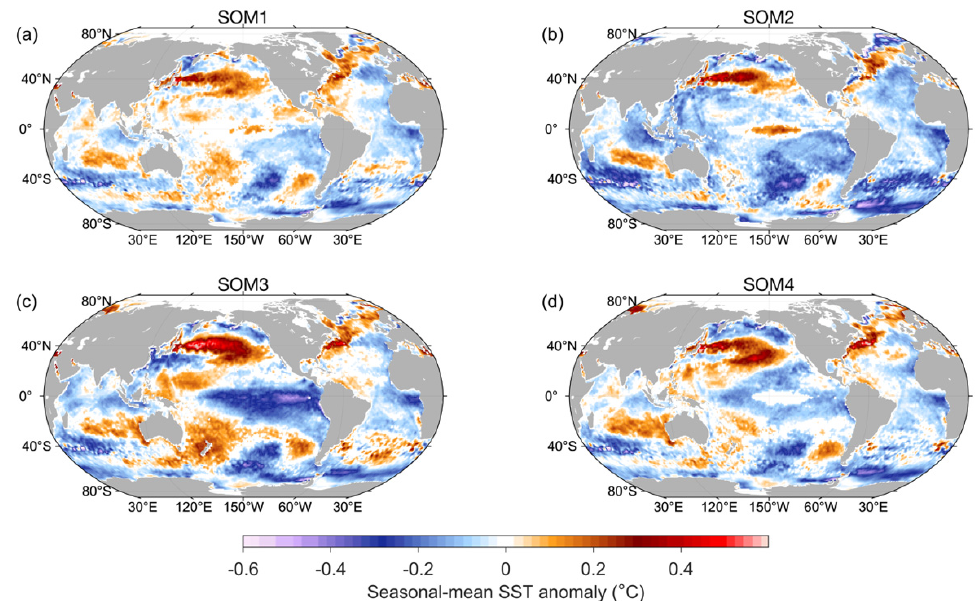
Figure 6. The same as Figure 5 except for the composites of the winter-mean SST anomalies. The shaded area passes the p = 0.05 significance test. The four plots are SST anomalies related to SOM1 ( a ), SOM2 ( b ), SOM3 ( c ), and SOM4 ( d ).